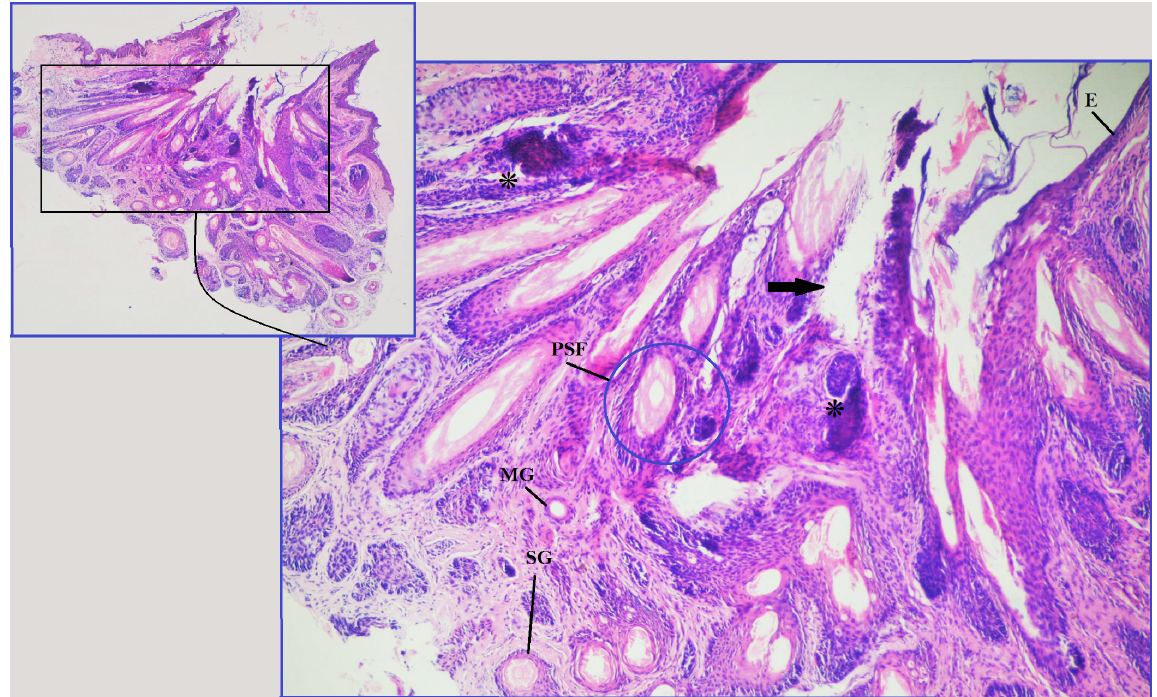
Figure 3: Photomicrograph shows lash follicle (*), its fibrous tract (arrow), epidermis (E), Molls gland (MG), sebaceous gland (SG) and pilosebaceous follicle (PSF).